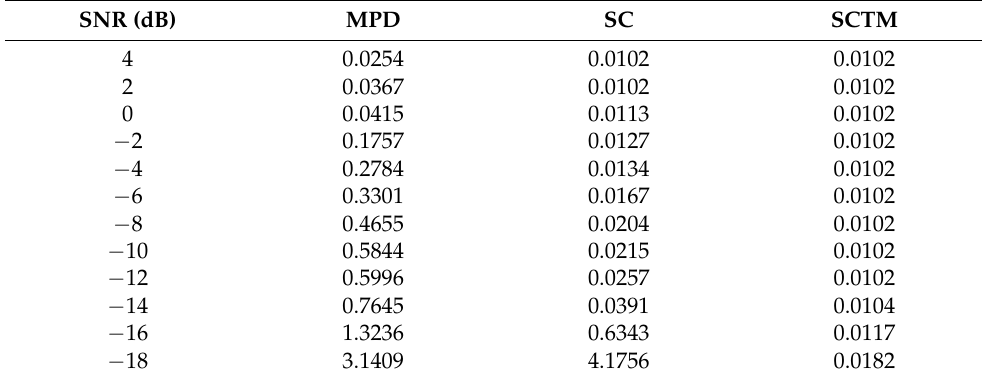
Table 5. Average PD estimation error.